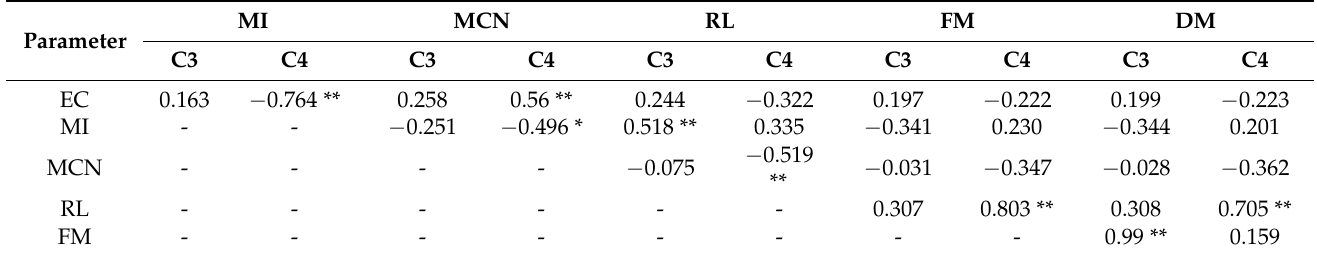
Table 3. Pearson correlation between salinity, genotoxicity, and growth parameters. V. faba roots